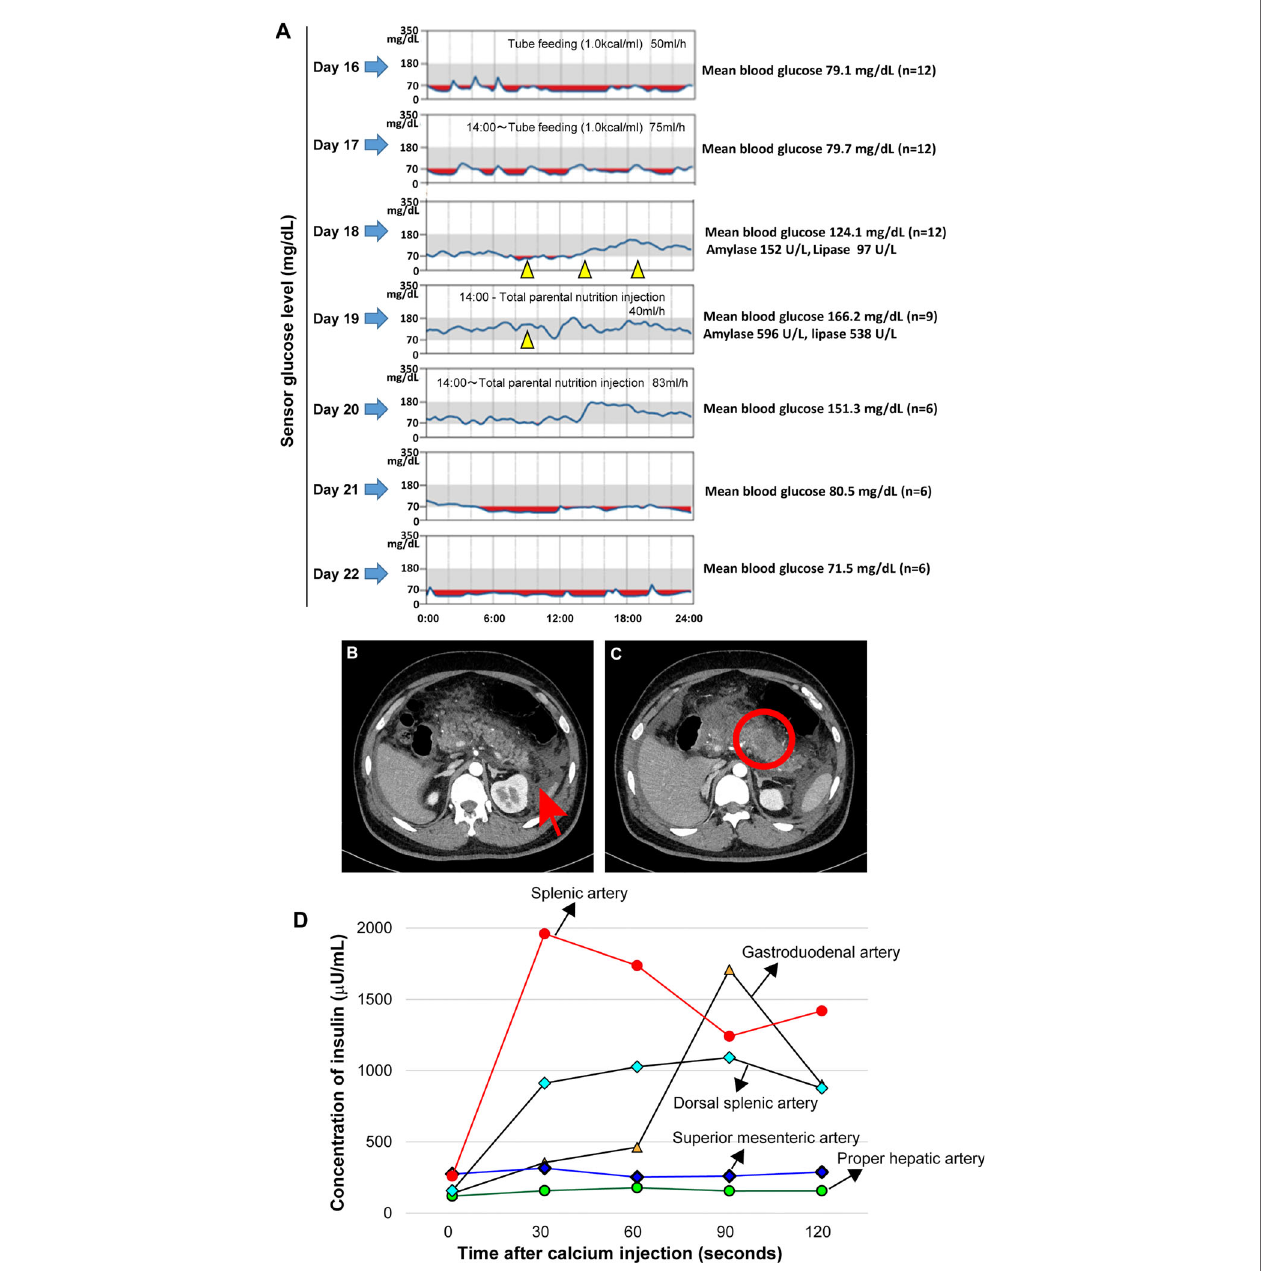
FIGURE 1 | Continuous blood glucose monitoring, mean blood glucose level before and after treatment with diazoxide and enhanced abdominal computer tomography fi ndings compatible with acute necrotizing pancreatitis on admission. Oral diazoxide improved the hypoglycemic state of the patient. The values of amylase and lipase described on day 18 are values before diazoxide treatment. The blood levels of pancreatic amylase (152 ! 596 U/L) and lipase (97 ! 538 U/L) increased on day 19. Arrow heads indicate treatment with 125 mg diazoxide. Red regions indicate the interval during which the sensor glucose level was less than 70mg/dl. During the tube feeding, we used Peptino (Terumo, Tokyo, Japan), which is a liquid digestive meal. We used ELNEOPA-NF No.2 injection from Otsuka Pharmaceuticals (Tokushima, Japan) for the total parental injection. (A) . Enhanced computer tomography (CT) images show enlargement of the pancreas with low- density areas in the pancreatic body (B) and peripancreatic fl uid collections. There is no evidence of a pancreatic tumor (C) . An arterial secretagogue injection (SASI) test shows insulin hypersecretion in the whole pancreases (D) . (cid:129) : Splenic Artery, ▲ : Gastroduodenal artery, ◆ : Dorsal splenic artery, ◆ : Superior mesenteric artery, (cid:129) : Proper hepatic